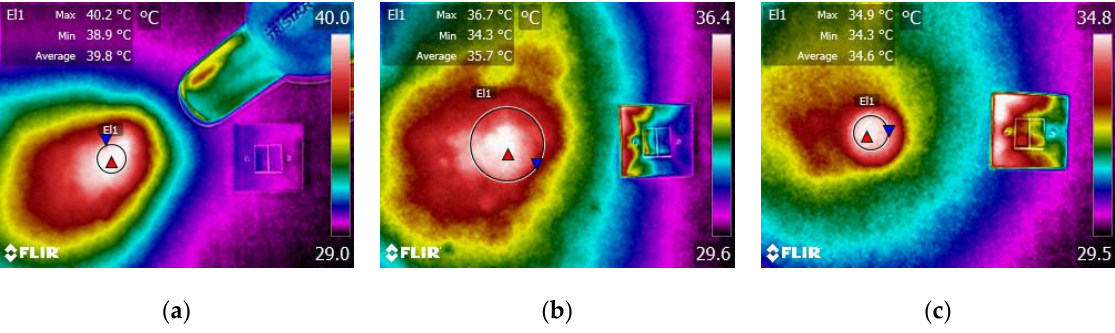
Figure 9. Finding a hidden distribution box by means of thermal incentive.